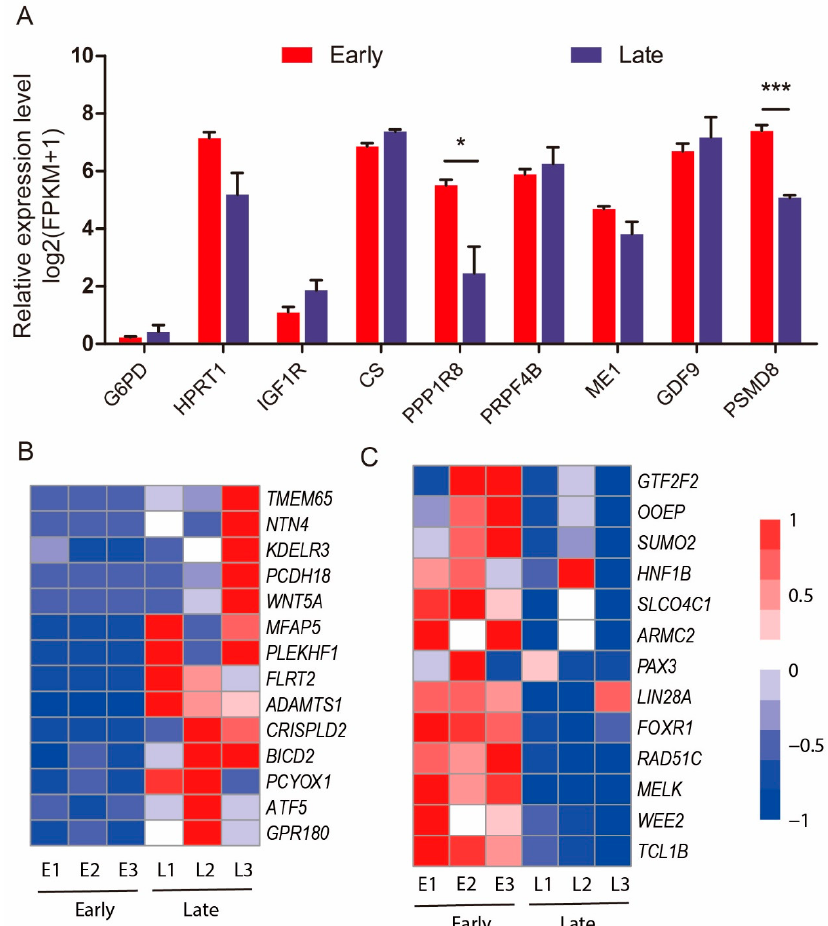
Figure 5. Oocyte-quality-related genes and transcriptional memory genes in pig SCNT reprogramming. ( A ) Relative expression level (log2 (FPKM + 1)) of several oocyte-quality-related genes. * p < 0.05, *** p < 0.001. ( B ) Heatmap of 14 active memory genes in early-dividing and late-dividing embryos. ( C ) Heatmap of 13 silent memory genes in early-dividing and late-dividing embryos.